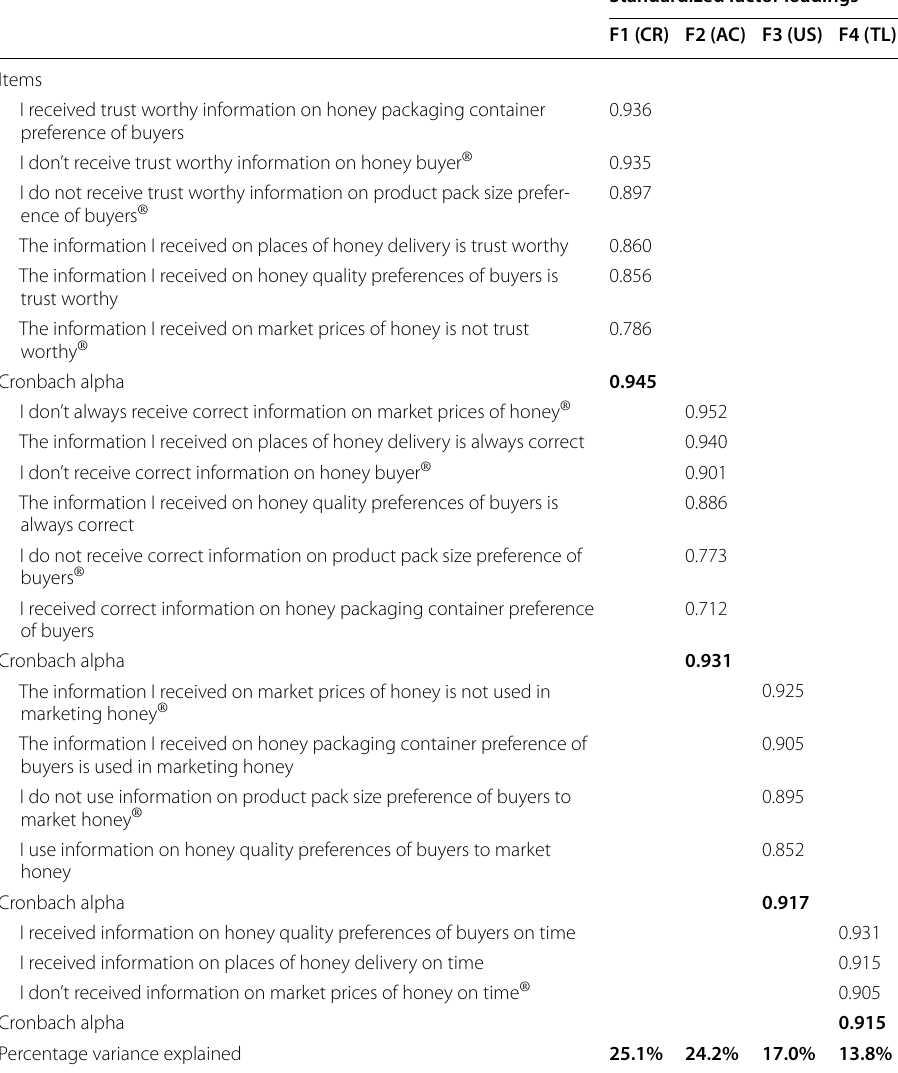
Table 4 Exploratory factor analysis results for market information